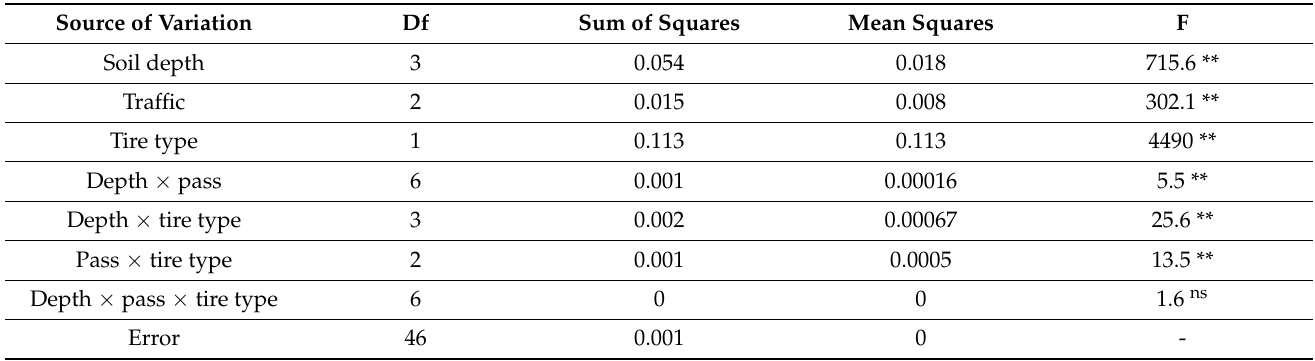
Table 3. Analysis of variance of soil bulk density change due to tire type, traffic and depth.